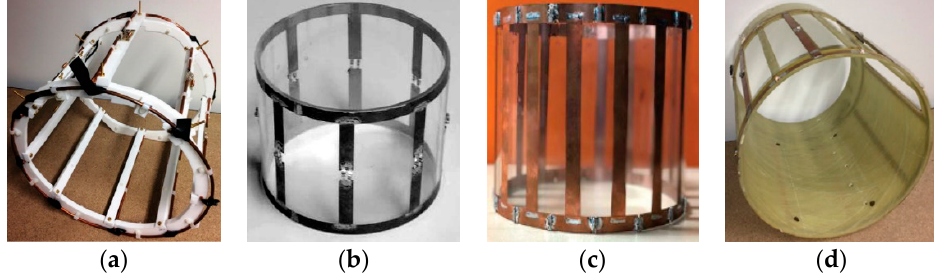
Figure 3. Birdcage coil implemented with different conductors: ( a ) Cylindrical wire [86]; ( b ) Rectangular strip [40]; ( c ) Rectangular foil [77]; and, ( d ) Rectangular foil etched on a flexible printed circuit board [86].